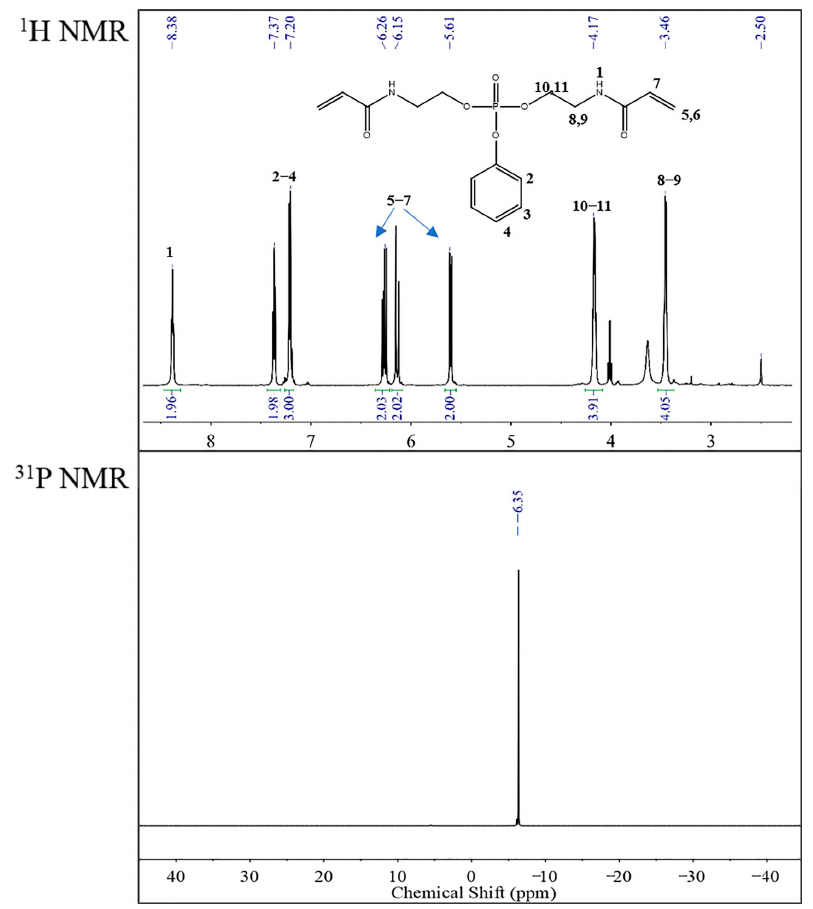
Figure 3. 1 H NMR and 31 P NMR spectrum of PDHAA.